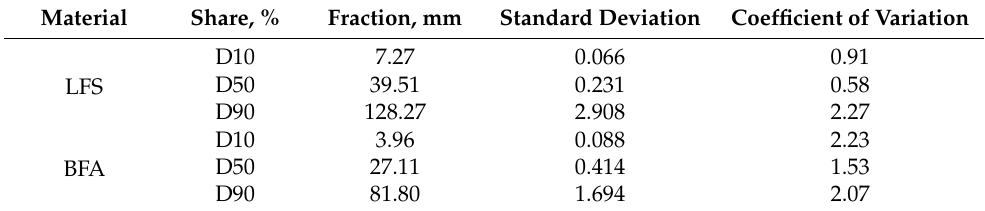
Figure 2. Particle size distribution and cumulative size distribution of BFA. Table 4. Characteristic shares of grain size distribution of furnace slag (LFS) and fly ash from the biomass block